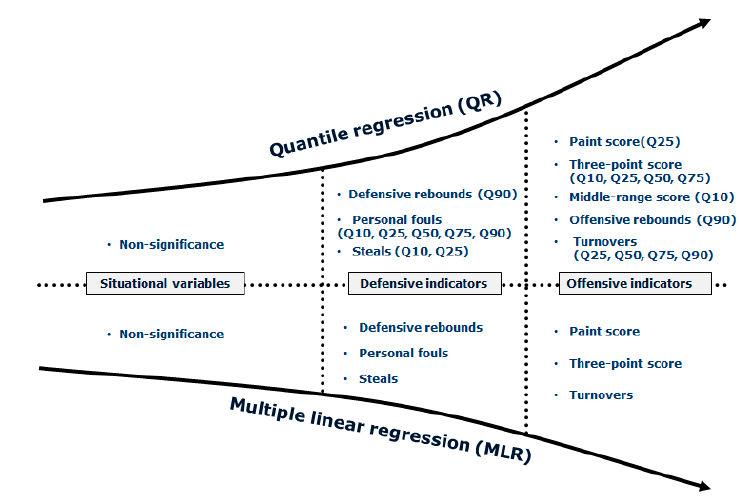
Figure 2. Summary of significant key performances indicators, according to the multiple linear regression (MLR) and the quantile regression (QR)